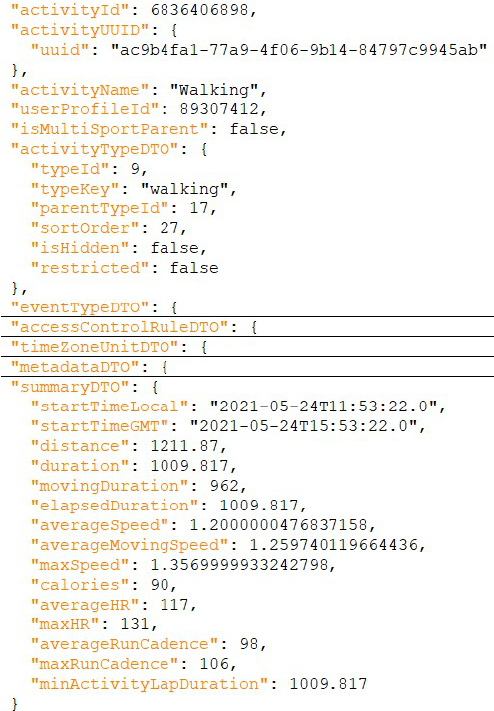
Figure 17. Reduced activity details automatically recorded by the Garmin device when the user went on a walk.